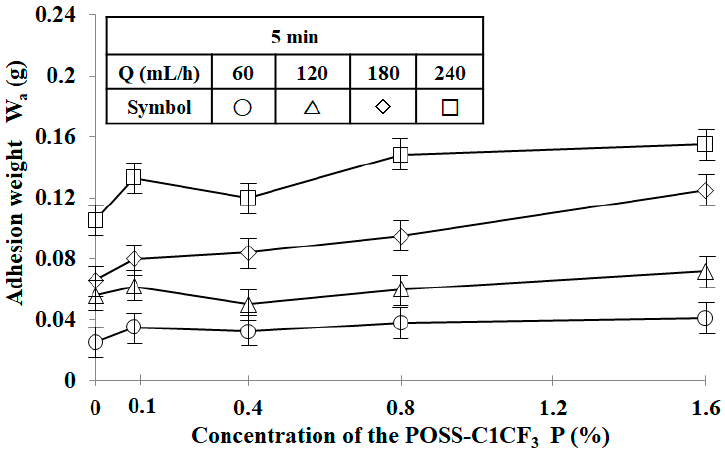
Figure 7. Relationship between W a and POSS C1CF 3 (3) concentration.